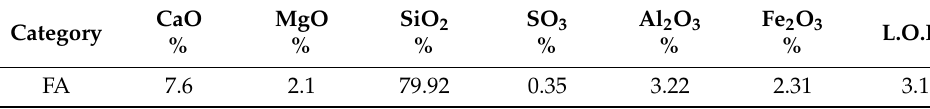
Table 2. Chemical composition of fly ash.